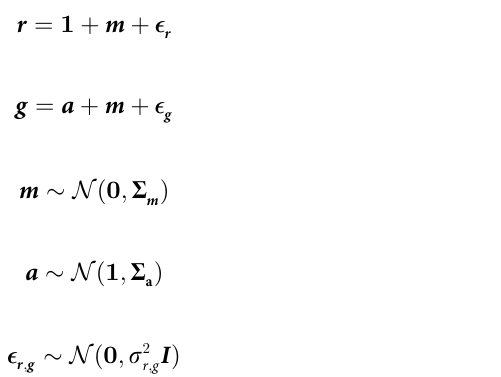
Fig 2. TMAC infers activity and hyperparameters from synthetic data. A) Diagram of the structure of TMAC. The green channel is modeled as the sum of the calcium activity, motion artifact, and independent gaussian noise. The red channel is modeled as the sum of the motion artifact and independent gaussian noise. The motion artifact is shared between the two channels. B) Top: fluorescence from a synthetic green and red channel. Middle and bottom: inferred activity and motion compared with the true activity and motion. C) Correlation squared between estimated activity from TMAC and true activity over many synthetic datasets. D) Violin plot of inferred and true parameter values when fitting